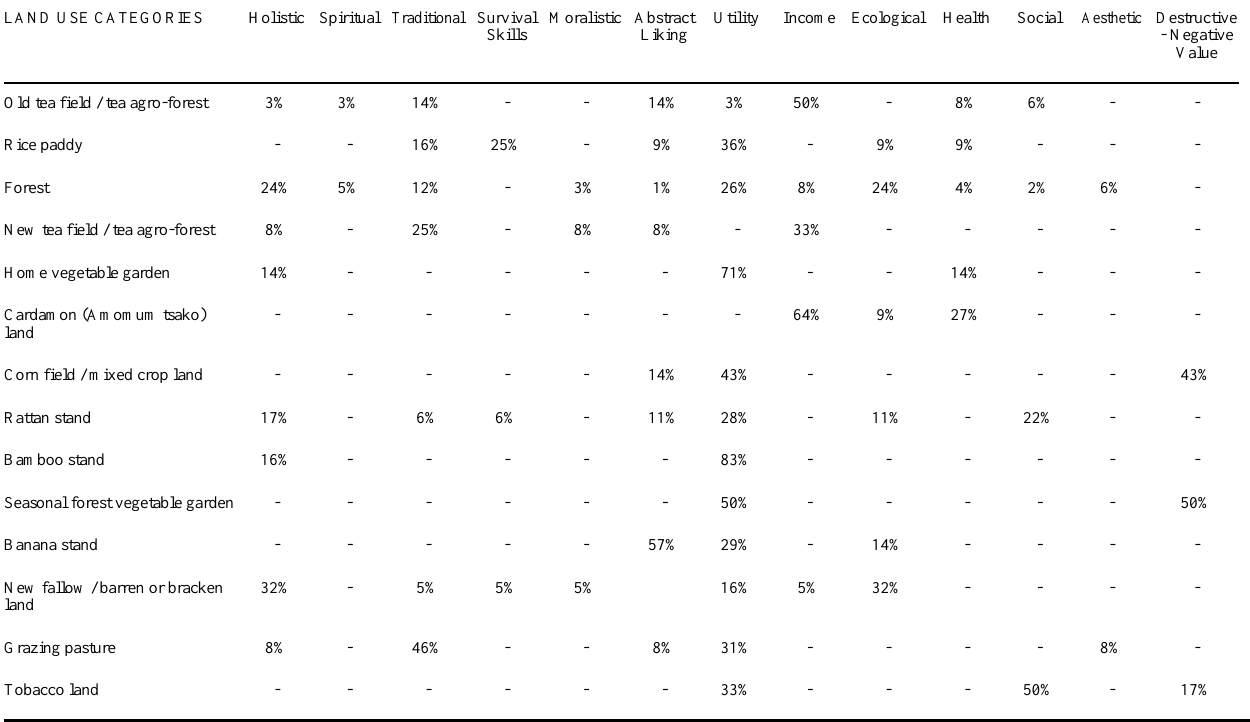
Table 3. Coded valuation schemata of the proportion of informants that indicated a particular value orientation toward land use